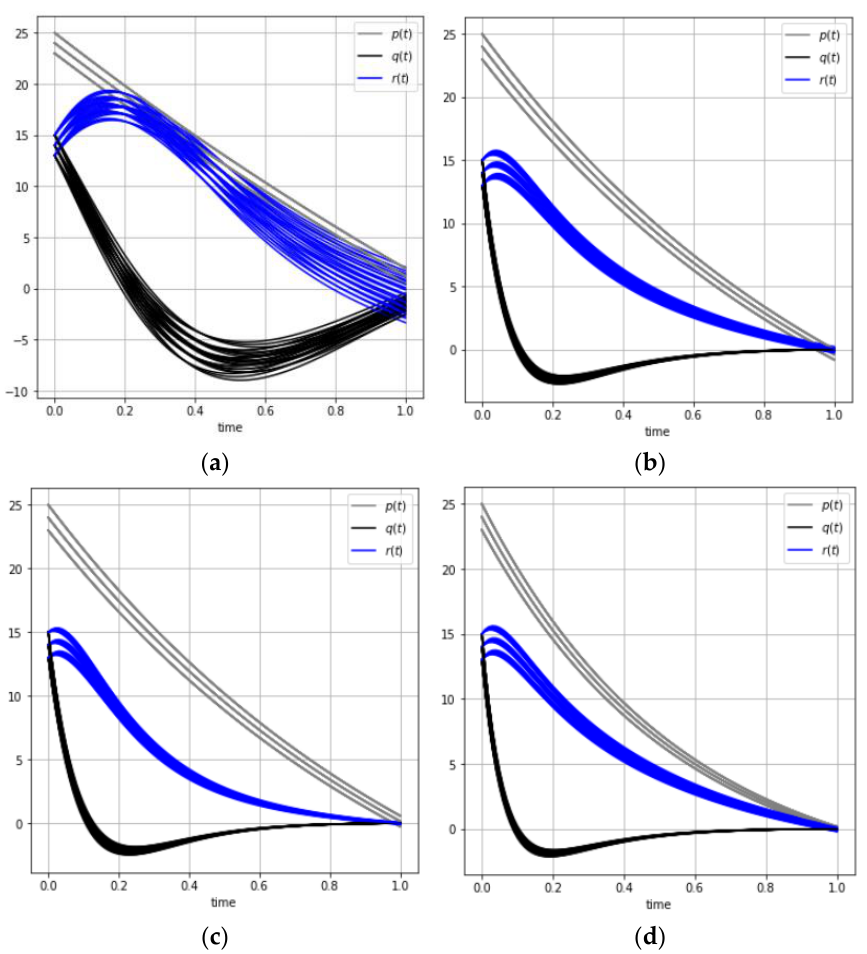
Figure 5. The behavior of the satellite coordinates p , q , r for different mini-batch sizes: ( a ) d = 1; ( b ) d = 10; ( c ) d = 20; ( d ) d =